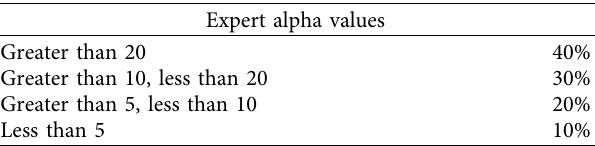
Table 2: Expert alpha values based on their research output in high impact